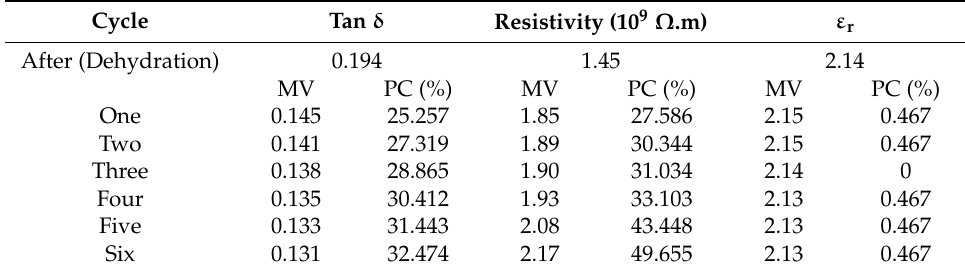
Table 3. Change in dielectric properties of oil with number of passes. Cycle Tan δ Resistivity (10 9 Ω .m) ε r After (Dehydration)